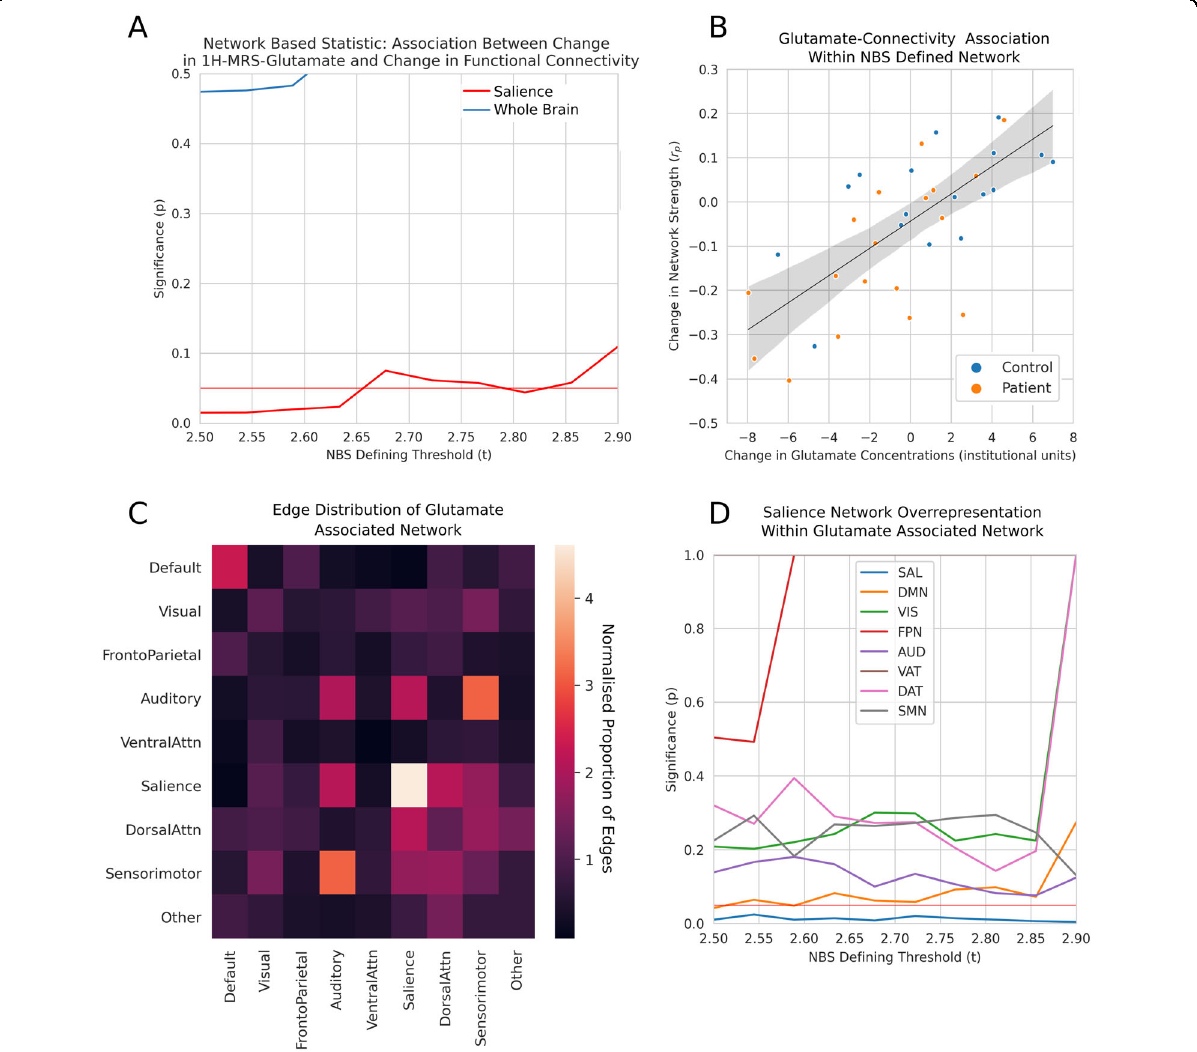
Fig. 3 Study B: riluzole associated change in glutamate concentrations and network connectivity. A When analysis is constrained to the salience network, at certain NBS thresholds there is a positive association between change in glutamate concentrations and change in connectivity following riluzole administration. The horizontal red line represents the p < 0.05 threshold, the other red line represents statistical signi fi cance when analysis is constrained to the salience network, while the blue line represents statistical signi fi cance for the whole brain analysis. B Illustration of the change in glutamate — change in connectivity relationship at a single threshold. Change in mean connectivity within the glutamate associated network for the NBS threshold of t = 2.5 is positively associated with the change in glutamate concentrations. C Heatmap illustrating the proportion of canonical intra- (diagonal) and inter-(off diagonal) network edges that overlap with the glutamate associated network. A normalised proportion of edges greater than one indicates a relative excess of edges compared to what would be expected to a even distribution of edges across the cortex. Salience network edges show greater overlap with the glutamate associated network than other canonical networks. D Results of permutation testing show that the excess of salience overlapping edges within the whole brain change in glutamate associated network is statistically signi fi cant across a range of NBS thresholds. The horizontal red line represents a threshold of p < 0.05, while the other lines represent the statistical signi fi cance of the overlap between a canonical network and the glutamate associated network. Only the salience network is signi fi cantly overrepresented, and this is at all thresholds. AUD auditory, DAT dorsal attention, DMN default mode, FPN frontoparietal, SAL salience, SMN sensorimotor, VAT ventral attention, VIS